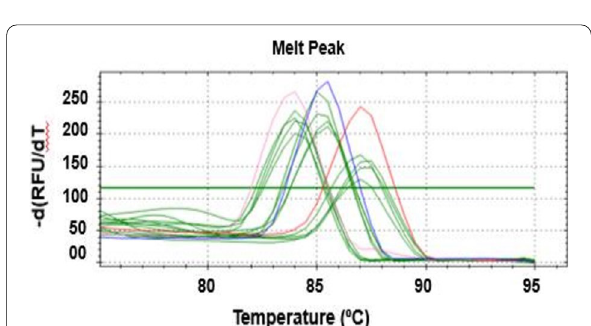
Fig. 2 Melting curve profile from the amplification of the genes GAPDH in the center-left peaks for BAMBI and right peaks for Survivin. The melting curves are displayed as the first negative derivative of the fluorescence versus the temperature. Thus, a peak can be seen at the melting temperature